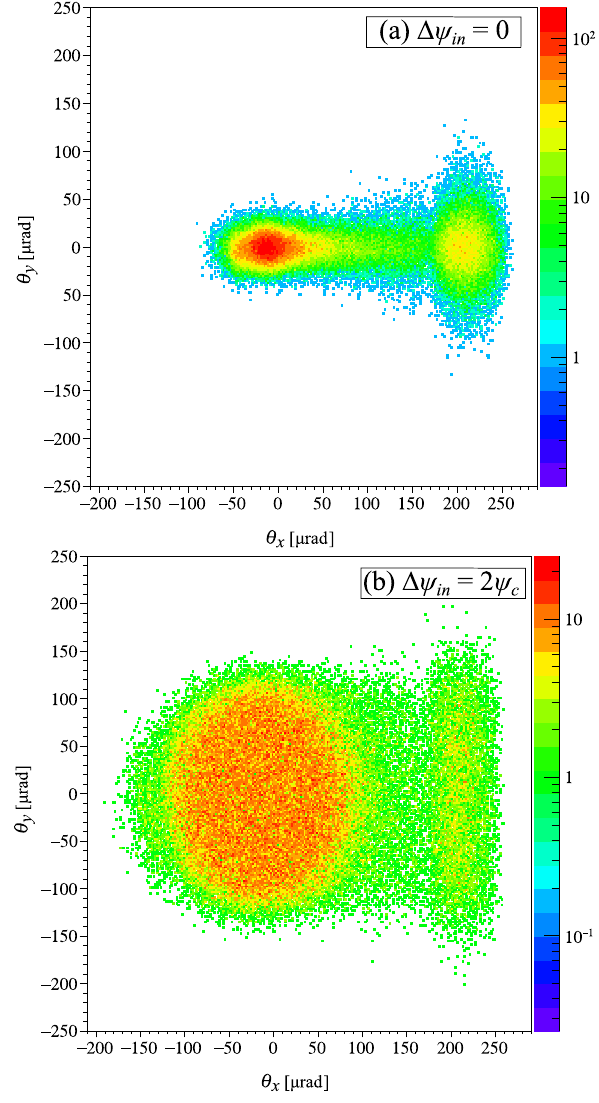
Fig. 5 Angular distributions of antiprotons after planar channeling in a bent crystal at optimal crystal parameters